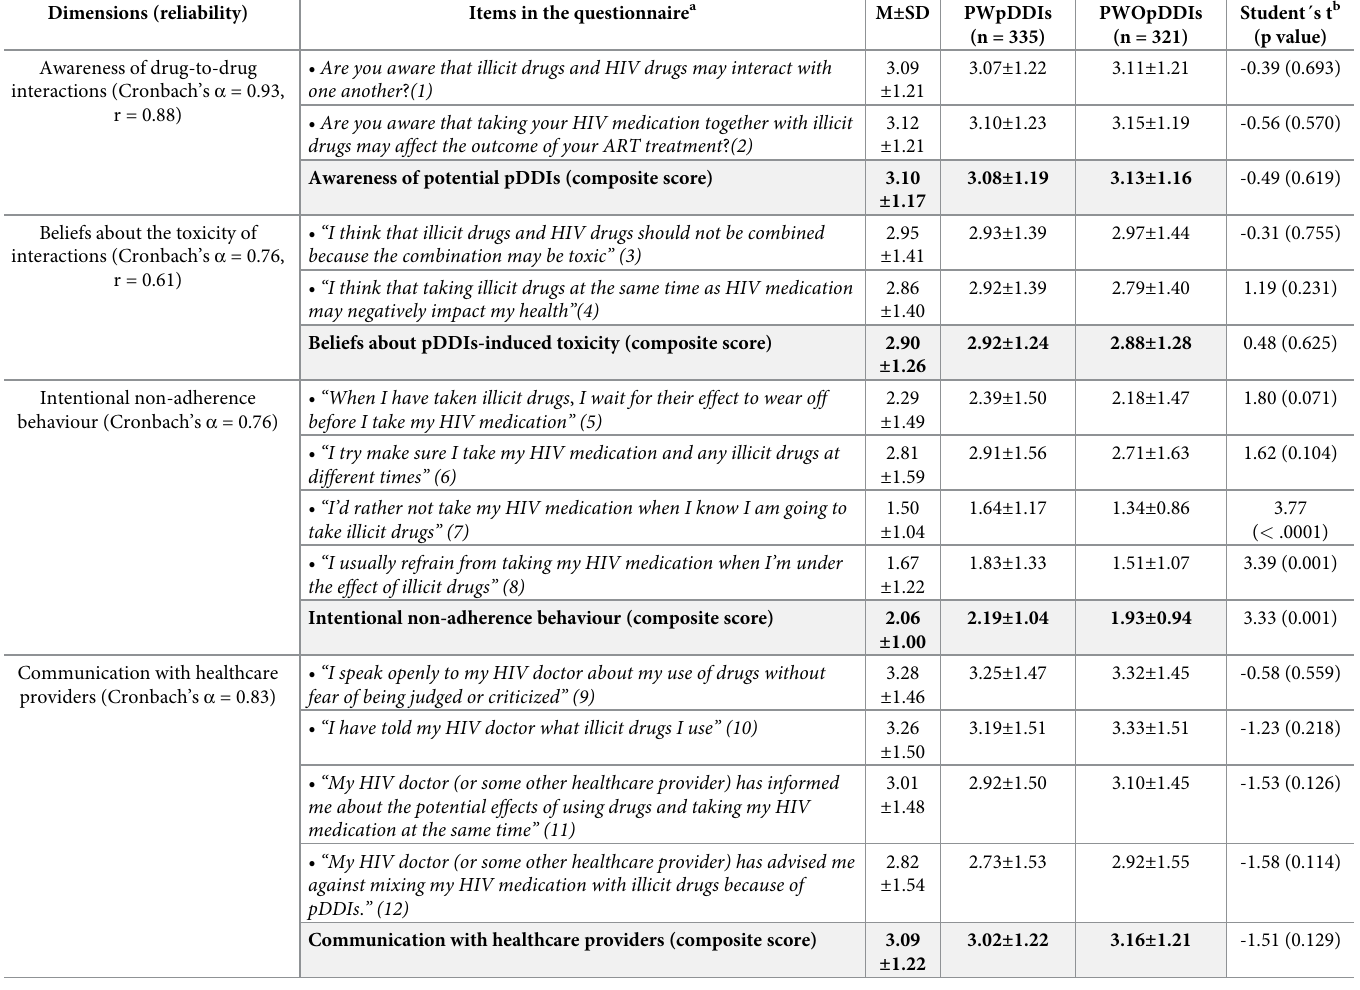
Table 3. Awareness and beliefs about interactions, intentional non-adherence, and communication with healthcare providers. Dimensions (reliability) Awareness of drug-to-drug interactions (Cronbach’s α = 0.93, r = 0.88)